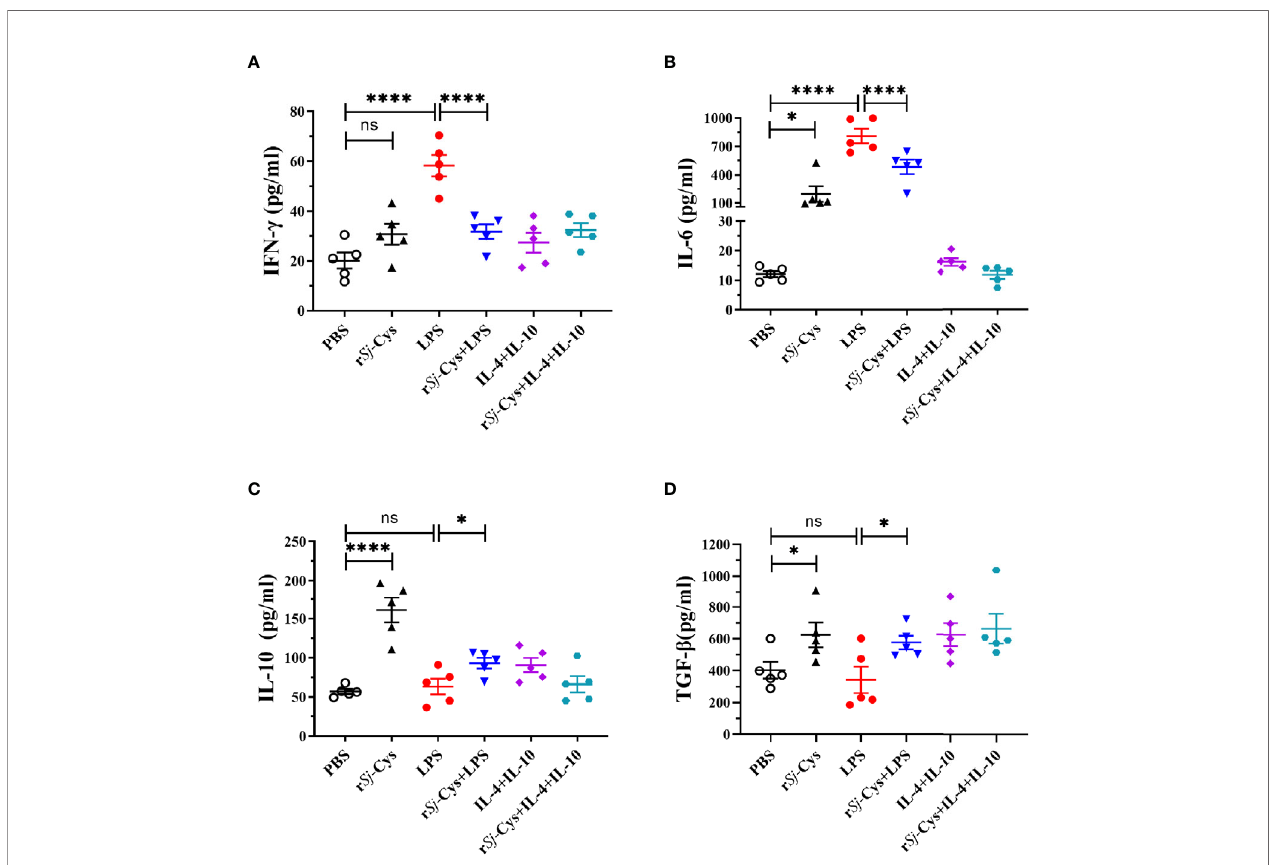
FIGURE 3 | r Sj -Cys induced BMDMs to secrete M2 macrophage-related cytokines IL-10 and TGF- b . Mature BMDMs were stimulated with PBS, r Sj -Cys (2 ug/ml), LPS (100 ng/ml), IL-4 (10 ng/ml) + IL-10 (10 ng/ml), r Sj -Cys + LPS, or r Sj -Cys + IL-4 + IL-10 for 24 h. The levels of M2-related cytokines IL-10 (C) , TGF- b (D) , and M1-related cytokines IFN-gamma (A) , IL-6 (B) were measured in the supernatant by ELISA. n = 5. The results are presented as mean ± SEM, ns, not signi fi cant, * P < 0.05, ** P < 0.01, *** P < 0.001, **** P <